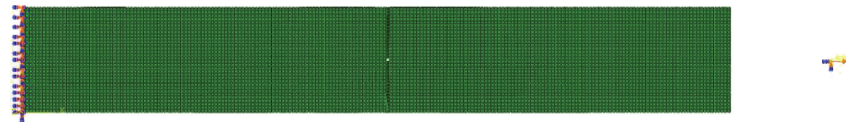
Figure 6: Schematic diagram of boundary